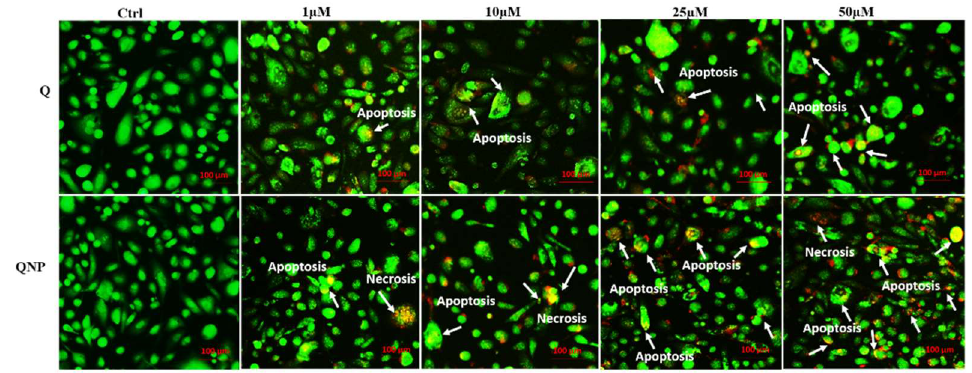
Figure 6. Fluorescence micrographs of EB/AO double stained HeLa cell line treated with different concentrations of Q or QNPs for 48 h. Apoptotic (light orange) and necrotic (dark orange) cells are indicated by arrows.